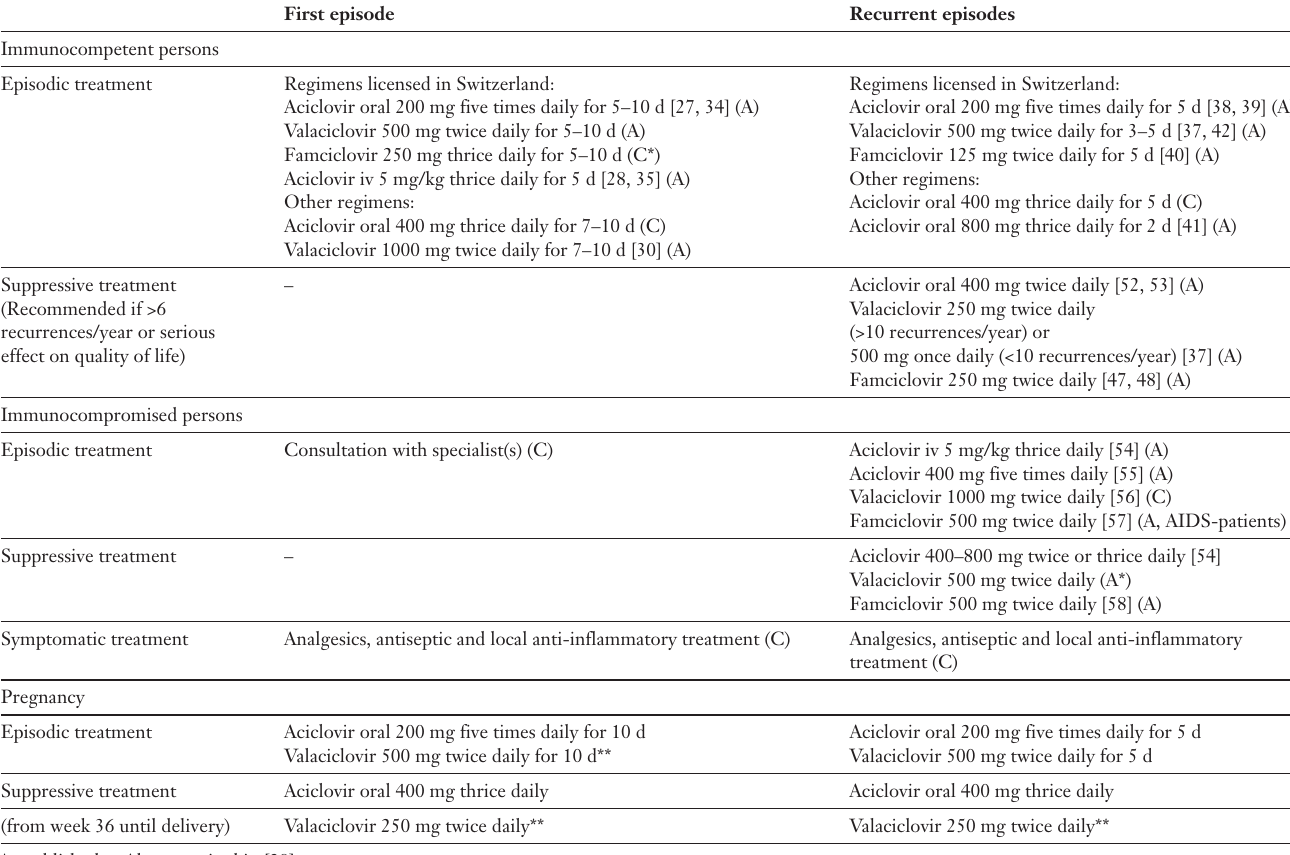
Treatment of genital